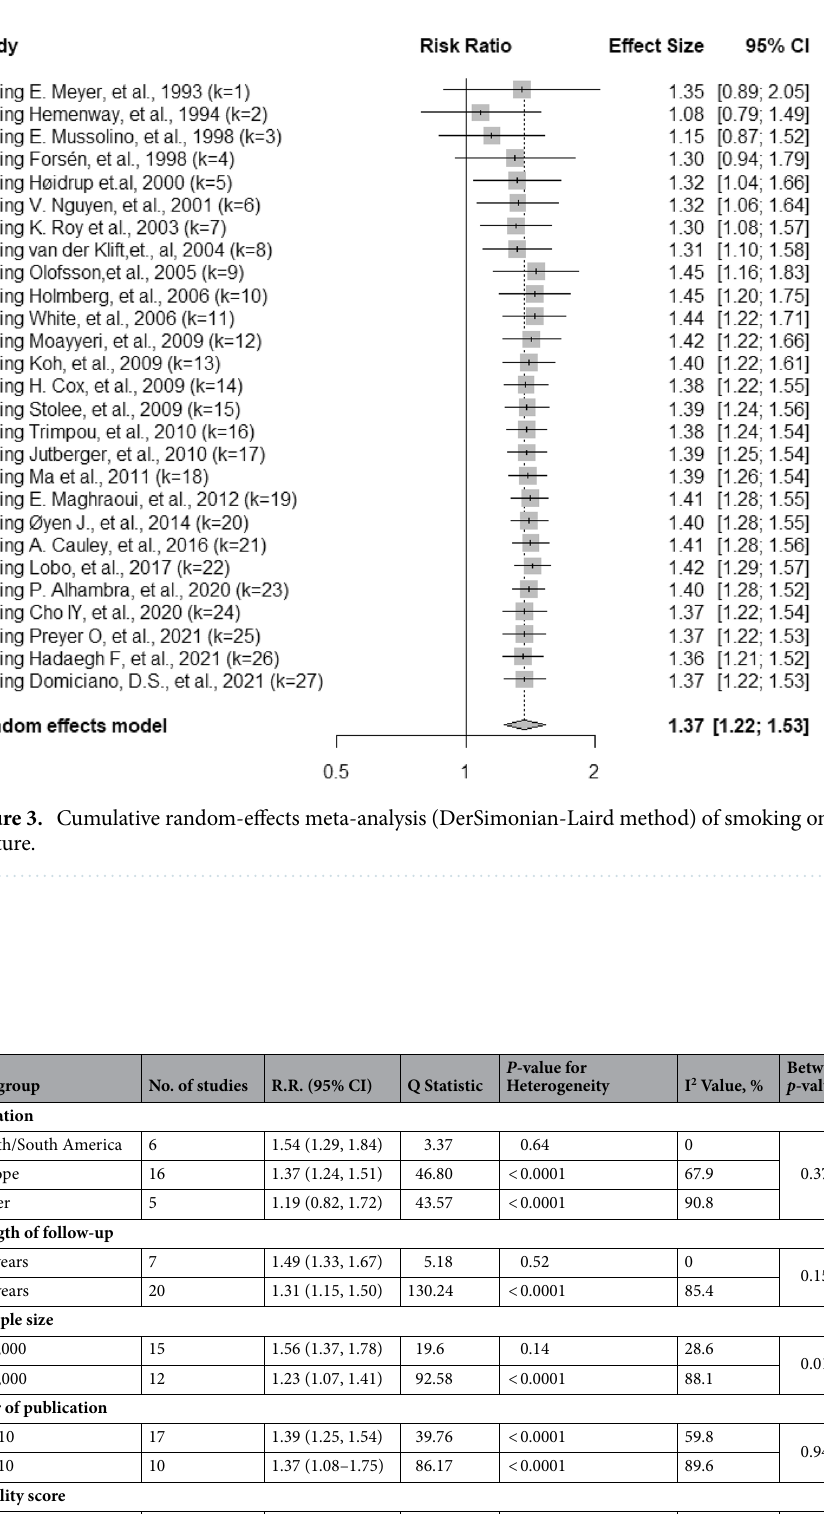
Table 3. Stratified analyses of the risk ratio of fracture associated with smoking, by subgroups. The frequentist approach and random-effect model were used for analysis unless noted otherwise.